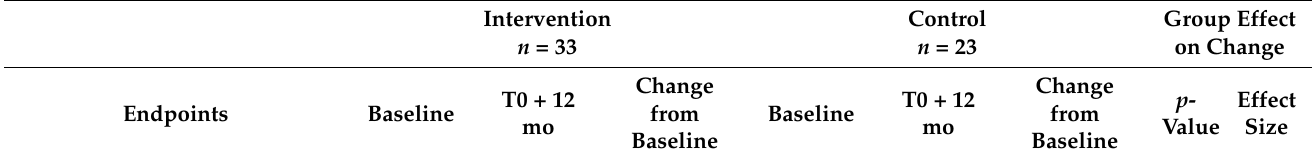
Table 5. Self-esteem and quality-of-life endpoints at 12 months.